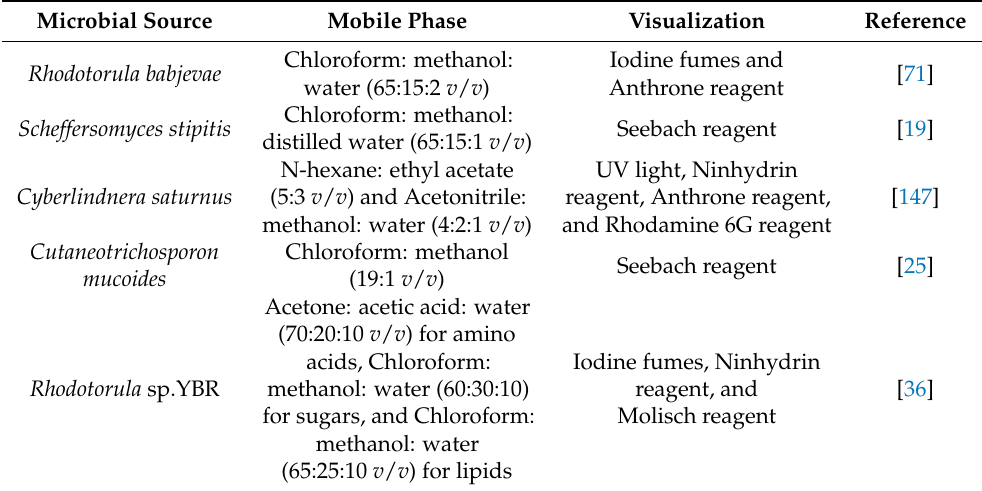
Table 4. Solvents and chemical treatments for visualization of TLC spots used for characterization of BS produced by